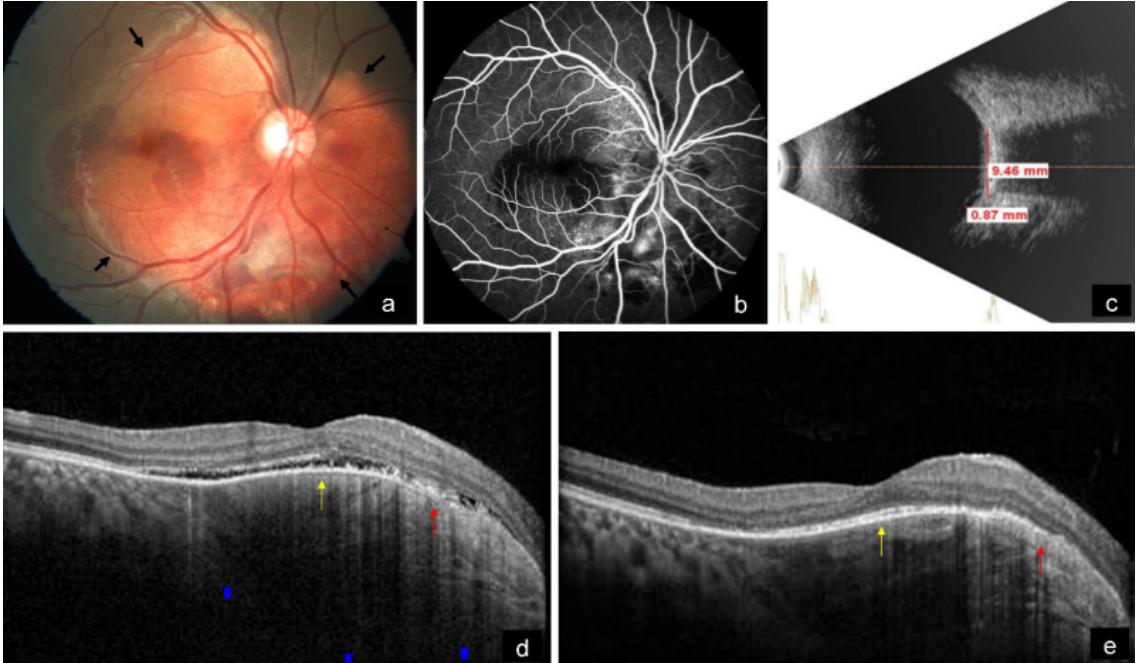
Figure 3: a) Color fundus photograph of the right eye shows a subretinal, yellowish-orange colored lesion in the peripapillary area involving the macula (arrows) with subretinal hemorrhage over the macula and inferior to the optic disc. b) On FFA, the lesion shows granular hyperfluorescence with areas of blocked fluorescence in mid-phase. c) B-scan shows a hyperechoic choroidal lesion with back shadowing. d) EDI-OCT shows an increase in choroidal thickness (blue arrows) with elevated RPE, along with CNV (red arrow) and subretinal fluid (yellow arrow). e) EDI-OCT shows scarred CNV (red arrow) with resolution of subretinal fluid (yellow arrow) after 1 month of intravitreal injection of Ranibizumab.